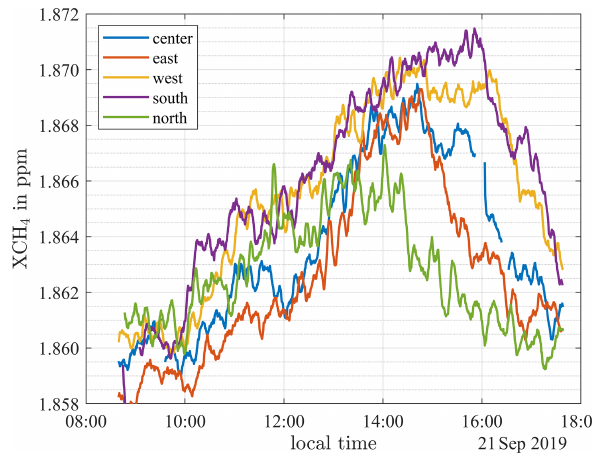
Figure 11. CH 4 measurement values (5min average) from all five stations during our Oktoberfest 2019 campaign on 21 September 2019. The concentration gradients between the single stations are clearly visible, which indicates the presence of strong CH 4 sources in the